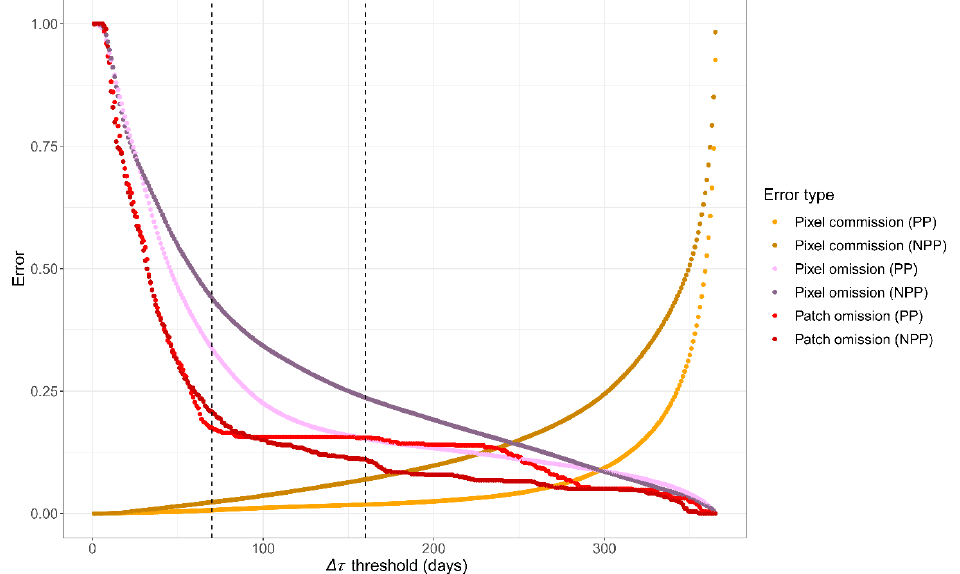
Figure 5. Effects of varying the ∆ τ threshold of summer pixels. ∆ τ is the predicted time interval between a fire and date of detection from Landsat, which acts as a proxy variable for burn-area resemblance. A lower ∆ τ indicates closer resemblance to burn-area pixels, while a higher ∆ τ indicates closer resemblance to unburn pixels. We trained random forest (RF) models that predicted ∆ τ from either (1) Landsat data that went through the entire preprocessing pipeline (PP) or (2) reflectance/VIs that had not underwent uniformization by weighted histogram matching (NPP). Different thresholds were applied to convert the continuous ∆ τ to binary fire/non-fire predictions. Errors of commission (unburnt pixels misclassified as burnt), pixel omission (proportion of burnt pixels missed), and patch omission (proportion of known burnt patches that had <6 correctly classified pixels) were calculated. The vertical dash lines represent the thresholds (70/160) we adopted to seed and grow fire scars in LTS